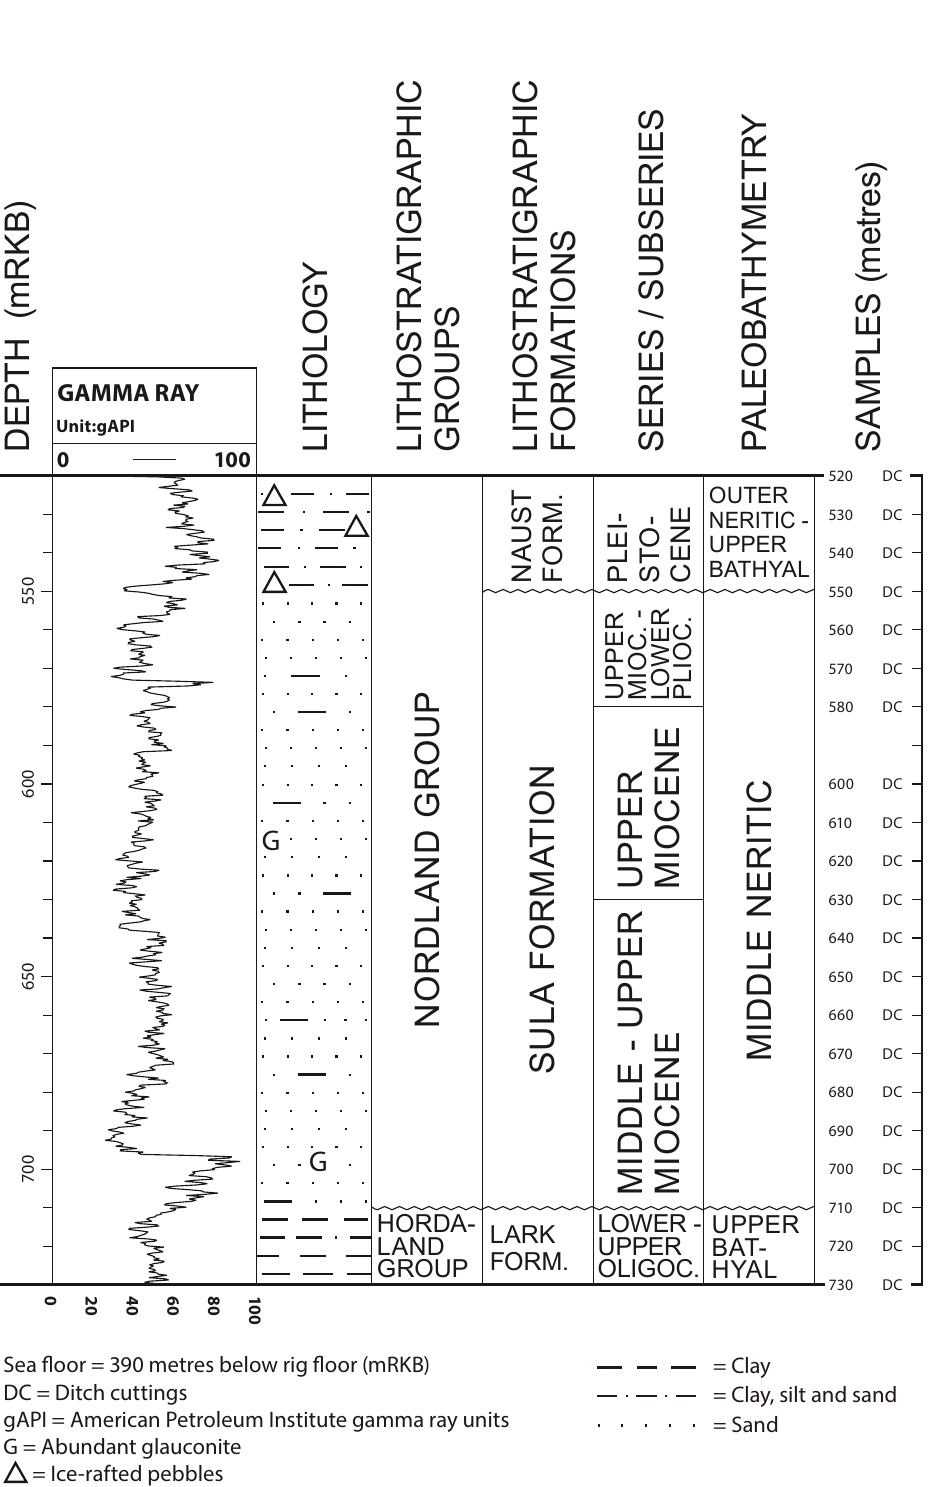
Figure 62. Well summary figure for the lower–upper Oligocene to Pleistocene in well 35/11–1 including gamma ray log, lithology, lithostratigraphic units, series/subseries, paleobathymetry and analysed samples, including the type section Fig. 62 for the Sula Formation (modified after Eidvin & Rundberg,